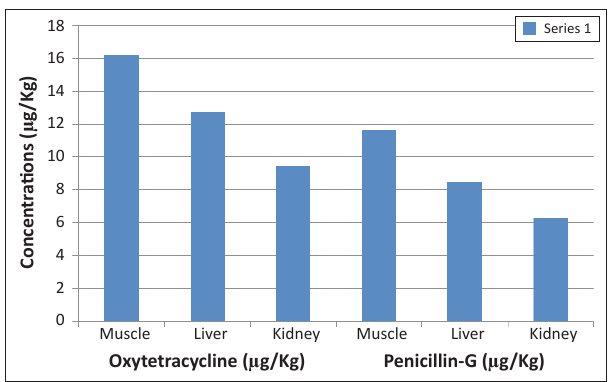
FIGURE 1: Mean distribution of oxytetracycline and penicillin-G residues in tissues of slaughtered cattle in south-western